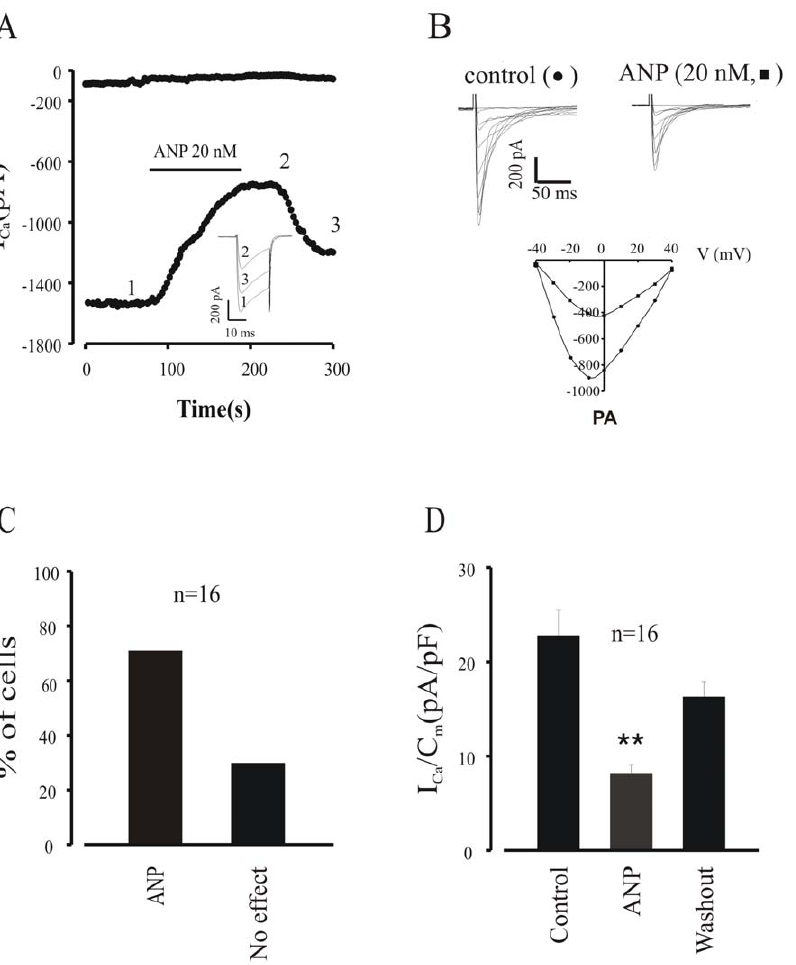
Figure 3. ANP depresses basal I CaL in EDS cardiomyocytes. A , Typical recording of I CaL from a single cell. Upon application of 20 nM ANP, rat 3–28, basal I CaL was decreased. This effect could be partially reversed by washout. The inset represents currents recorded as indicated by the mumbers in the time course diagram. B , I/V relationship: ANP decreased peak I CaL without a shift in the I/V relationship. C , percentage of cells responding to ANP. D , density of peak I CaL . EDS cardiomyocytes derived from ES cells, peak I CaL amplitude